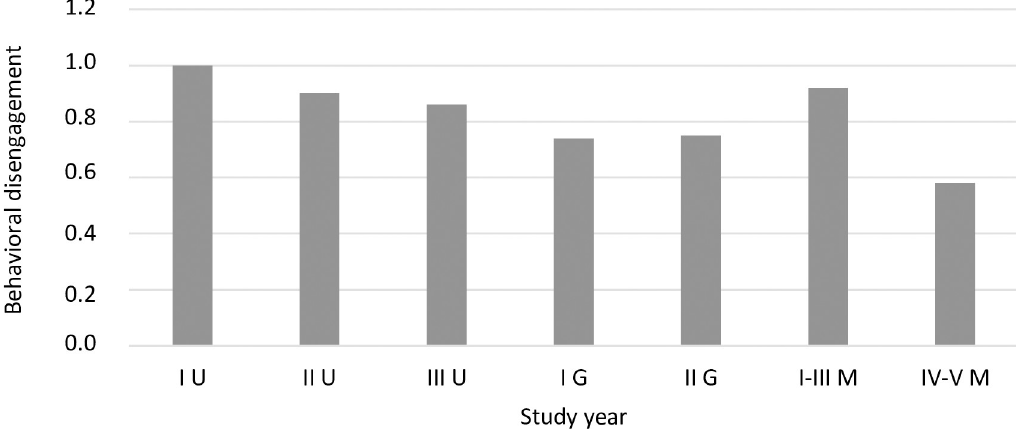
Fig 6. The coping strategy of behavioral disengagement (mean) among students in individual program years (F = 3.06, p = 0.006, eta = 0.03).